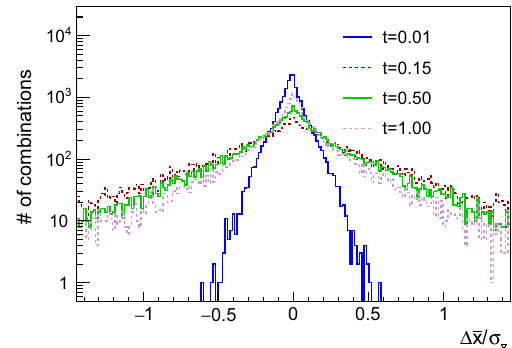
Fig. 10 Difference between the combined value of ¯ x obtained with the methodproposedhereandusingadirectlikelihoodcombinationrelative to the total uncertainty of ¯ x , shown for different values of the threshold t for systematic uncertainties. All pseudo-measurements comprise one relative and two absolute uncertainties